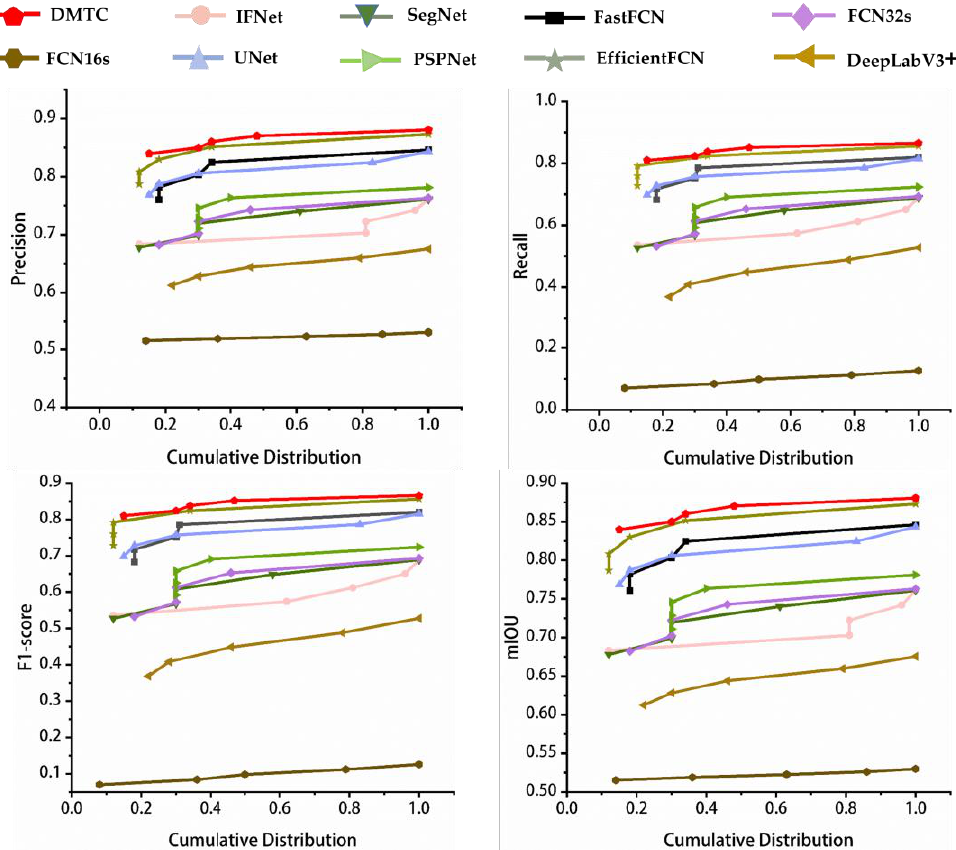
Figure 13. Quantitative comparison of four metrics, including precision, Recall, F1-score and mIOU, on the 5 random data images. Points (x, y) on the curve indicate that there are 100% * x% of images with metric values that do not exceed y.